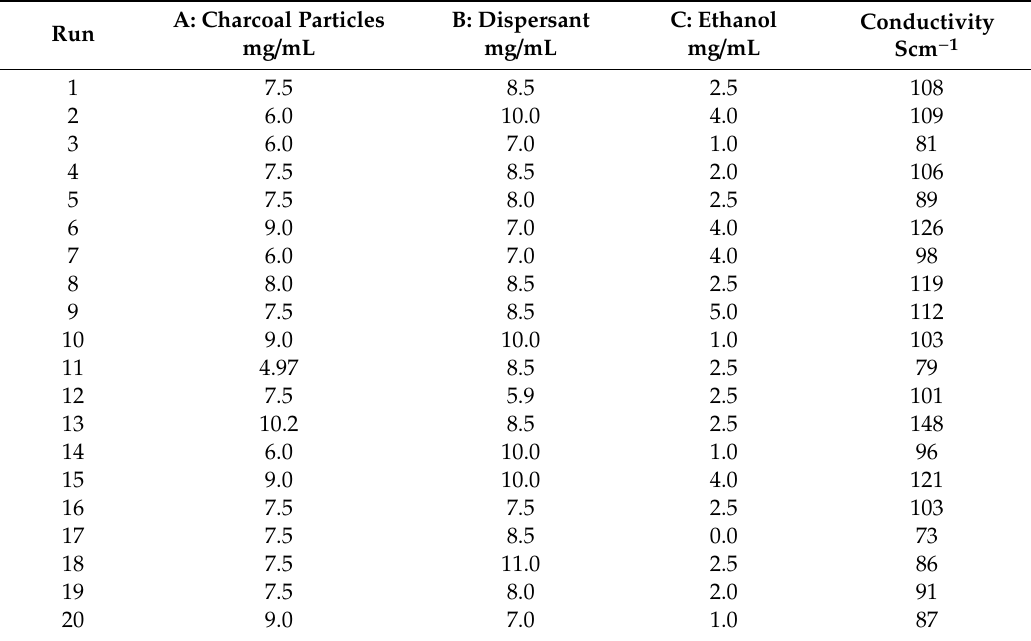
Table 5. Coating mixtures and improved conductivity of the fabric.